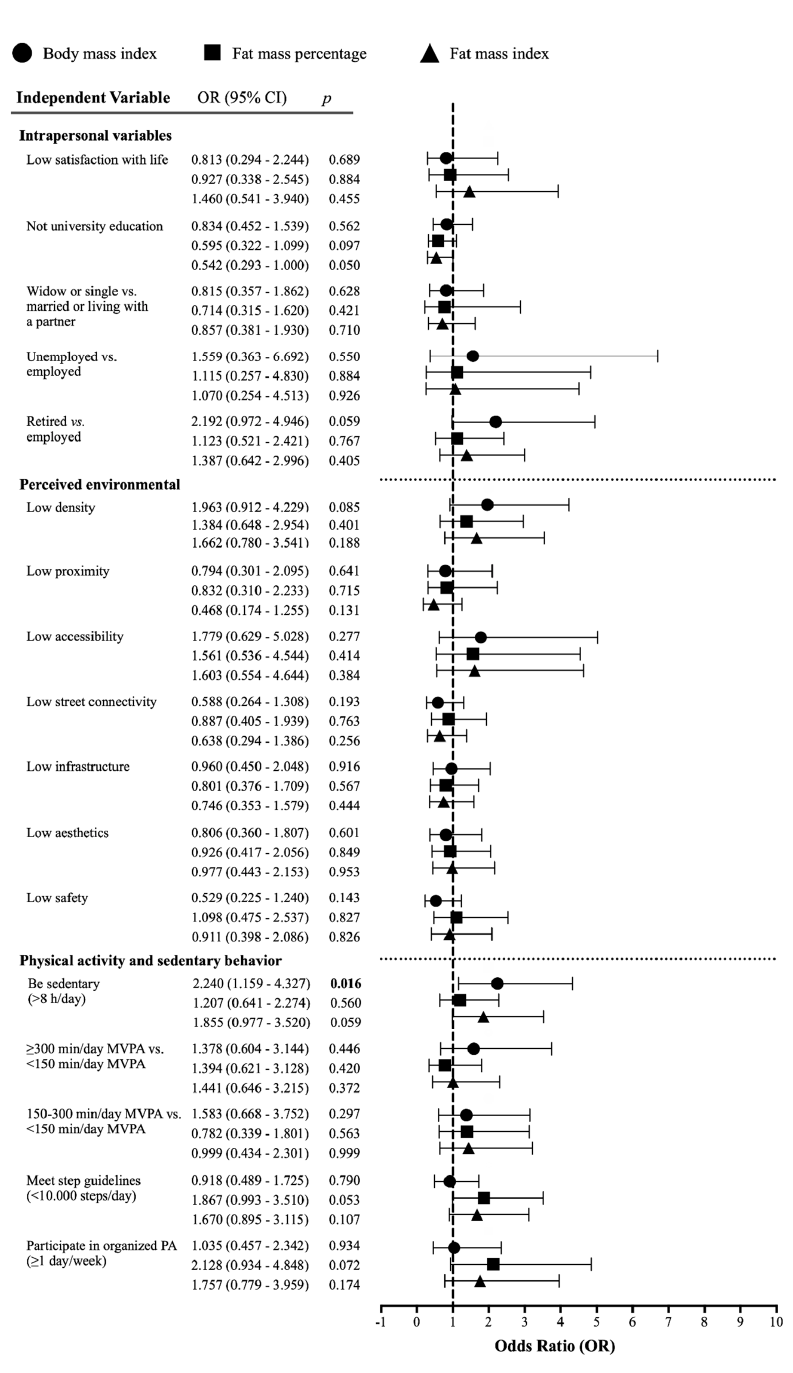
Figure 3. Forest plot showing the likelihood of a minimum relevant increase in body mass index (circles), fat mass percentage (squares), and fat mass index (triangles) during the seven-year follow-up according to intrapersonal, environmental, and device-measured PA and sedentary behavior variables at baseline. Boldfaced values: p < 0.05. Univariate logistic regressions were adjusted by country (dummy), baseline age, and follow-up duration. PA and sedentary behavior variables were additionally adjusted for accelerometer wear time. Abbreviations: OR: odds ratio; PA: physical activity; MVPA: moderate-to-vigorous physical activity.